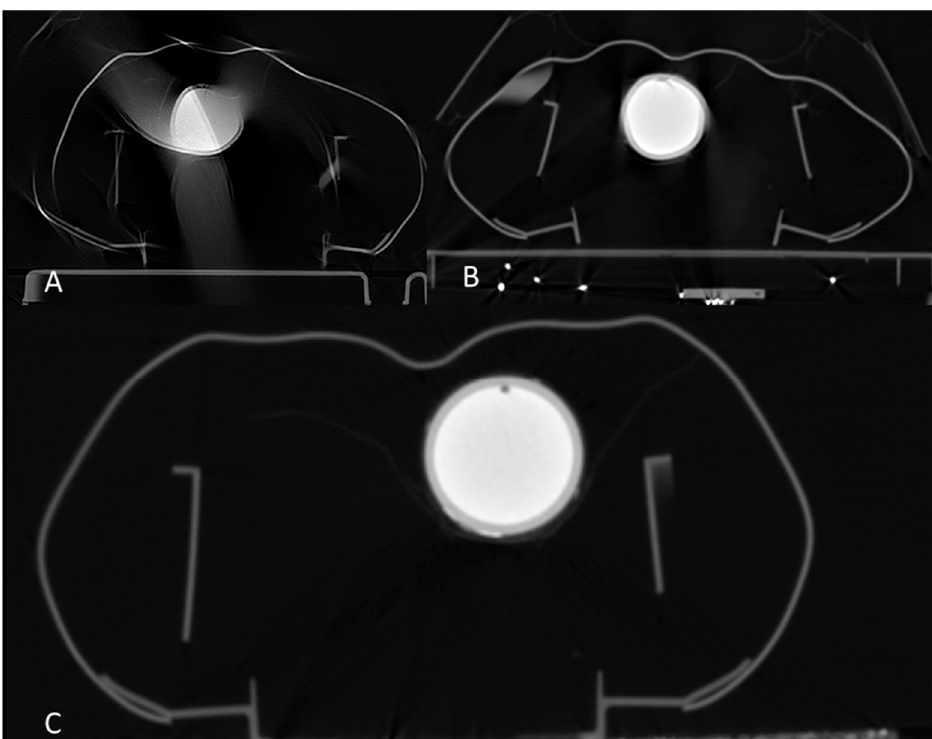
Figure 2. Examples of axial computed tomography images acquired with three different setups during ongoing cardiopulmonary resuscitation (CPR) with an automated chest compression device: standard trauma protocol during CPR with Autopulse ( A ) and ECG-triggered protocol during CPR using Autopulse ( B ) and corpuls cpr ( C ).